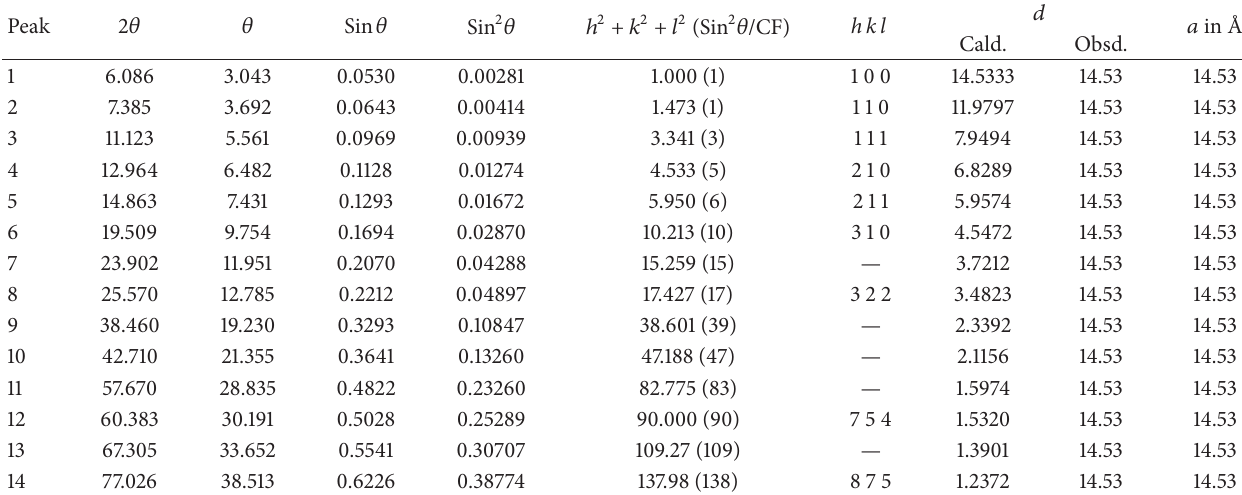
Table 6: Powder X-ray diffraction data of Ni(II)